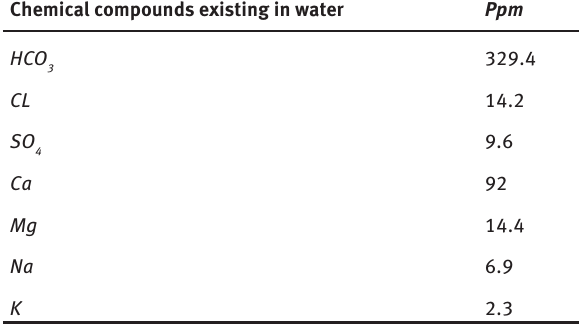
Table 6: Specifications of water.